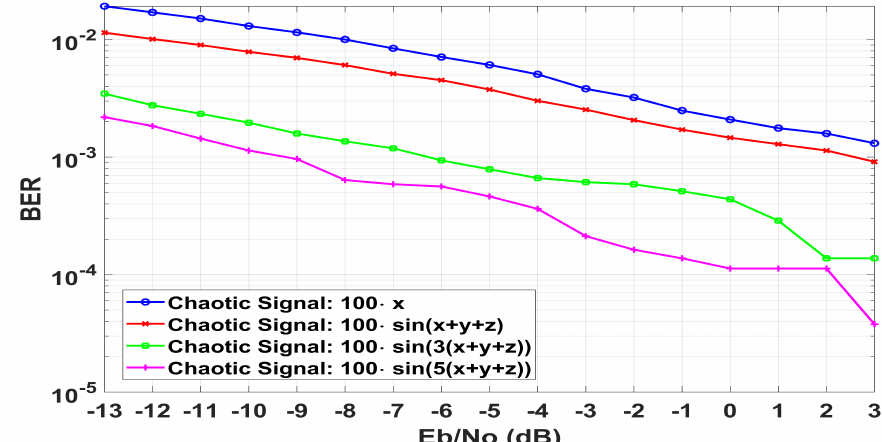
Figure 14. BER simulation